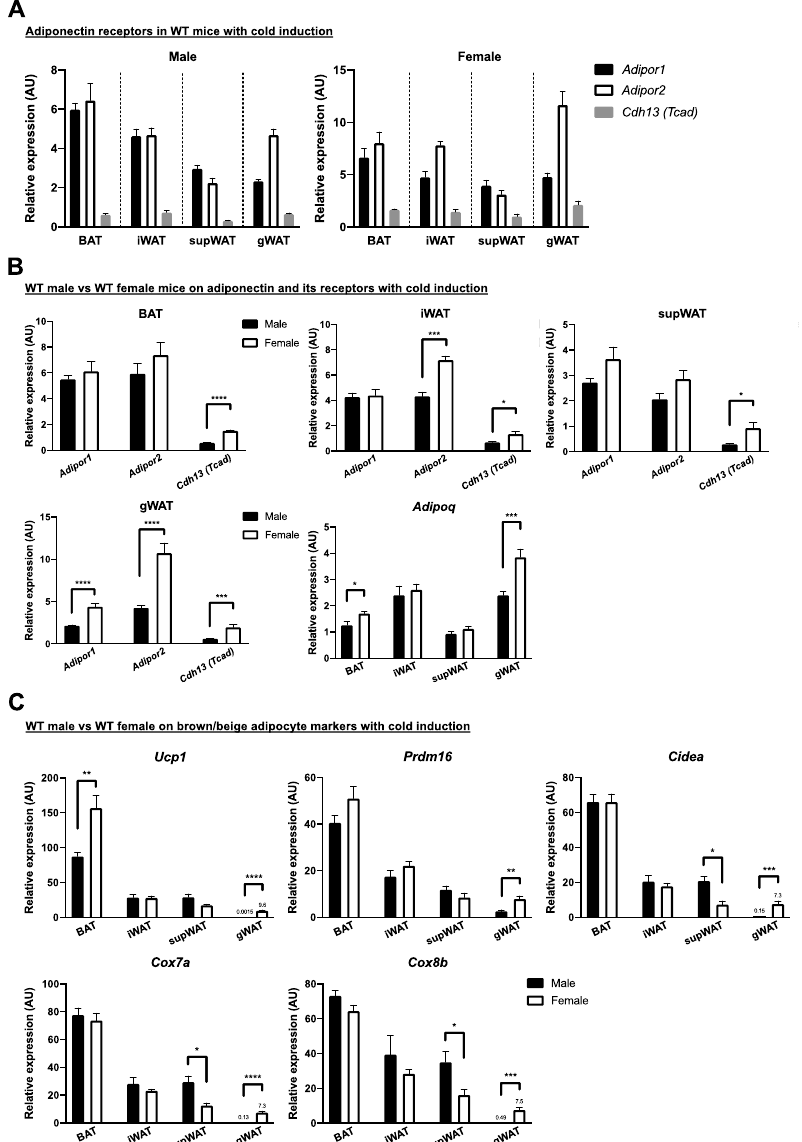
Figure 5. Female mice showed increased expression of adiponectin receptors and enhanced brown-adipocyte markers in classical brown and beige adipose depots after cold exposure. ( A ) Indicated adipose depots of male and female WT mice after cold acclimation were determined for expression of adiponectin receptors, including adiponectin receptor 1 ( Adipor1 ), adiponectin receptor 2 ( Adipor2 ), and T-cadherin ( Cdh13/Tcad ). ( B ) Comparison of expression of adiponectin receptors and adiponectin ( Adipoq ) between male and female WT mice was determined in iBAT, iWAT, supWAT, and gWAT, respectively. ( C ) Indicated adipose depots in male or female WT mice after cold acclimation were determined for expression of brown adipocyte (WAT browning/beiging) markers. Timeline and procedures were described in Figure 1. Classical iBAT, iWAT, supWAT (both of potential white adipose depots for browning or beiging) and gWAT in male and female WT mice were harvested, extracted and measured to evaluate adiponectin and its receptors and cold-induced thermogenic related genes ( n = 3–8 for each group). Data were presented as relative means (normalized to β -actin in arbitrary units, AU) ± SEM. * p ≤ 0.05; ** p ≤ 0.01; *** p ≤ 0.001; **** p ≤